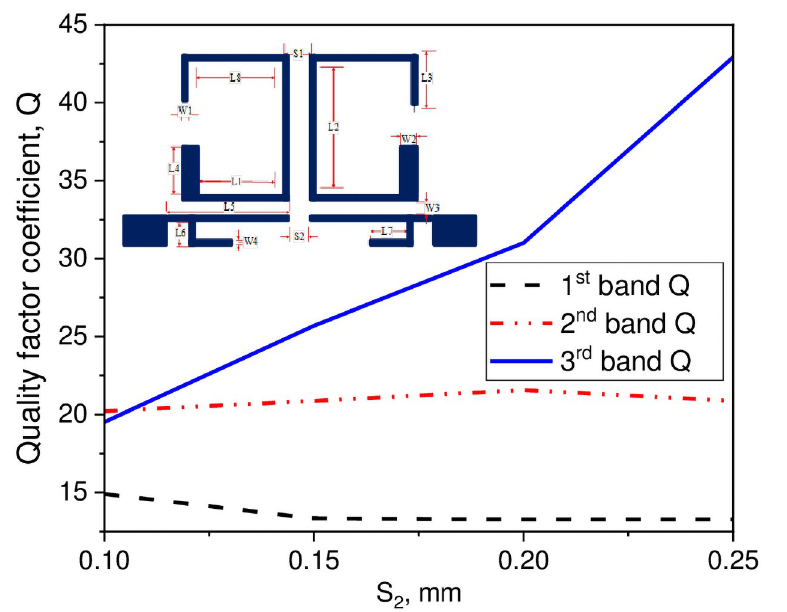
Fig 7. Graph of quality factor coefficient with S 2